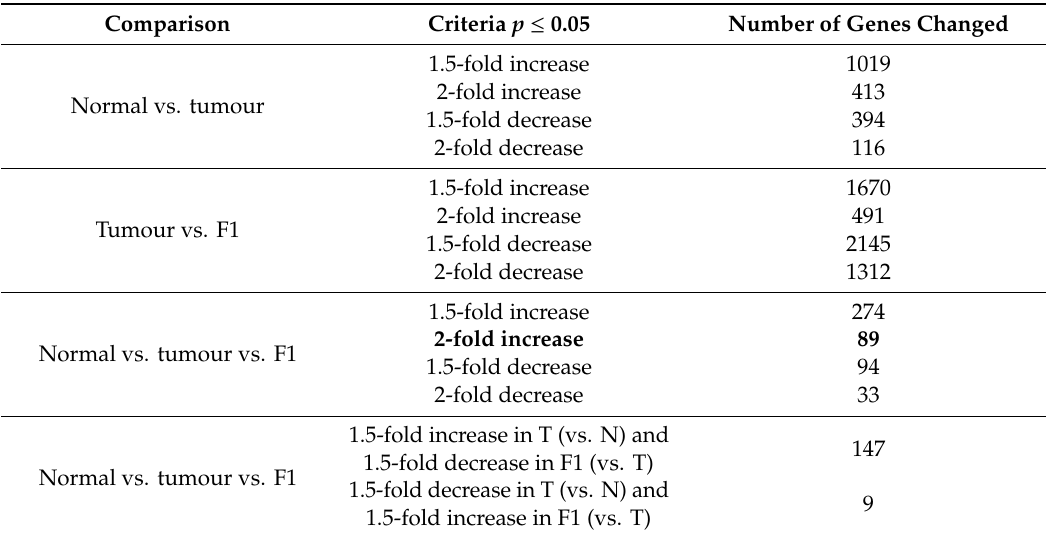
Table 5. The number of gene changes detected across the sample types, normal vs. tumour, tumour vs. F1 and triple comparison of normal vs. tumour vs. F1. All gene changes reported were statistically significant ( p ≤ 0.05). Genes that were 2-fold or greater increased were investigated further.